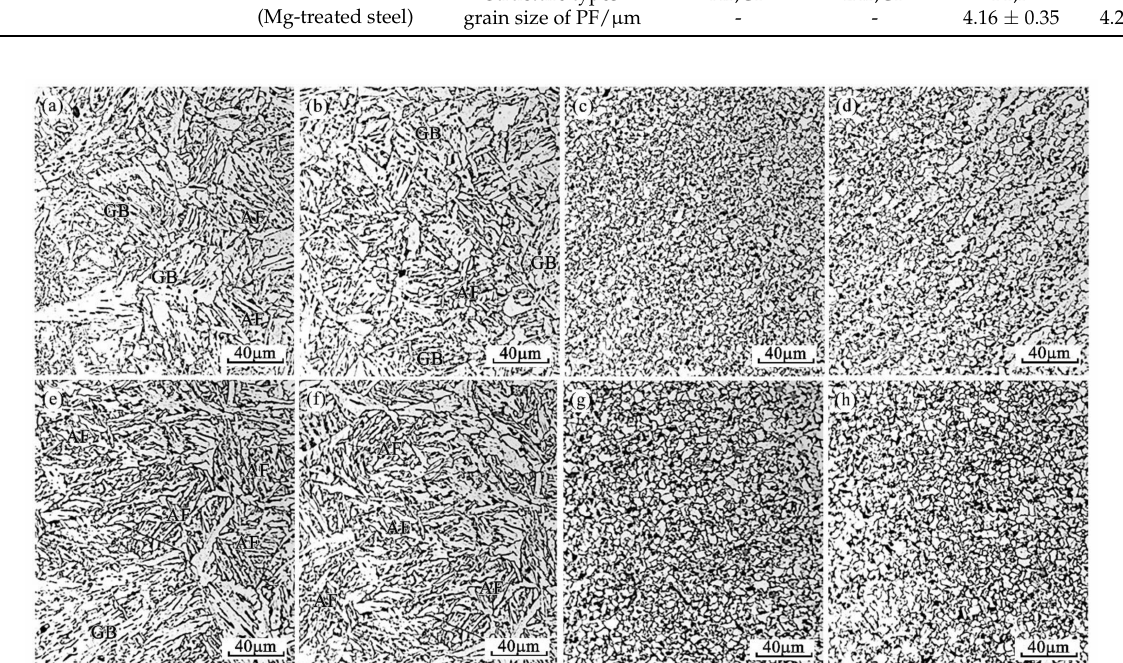
Figure 8. Microstructures of HAZ for No.2 steel. ( a – d ) CGHAZ, FGHAZ and ICHAZ under W1 procedure, ( e – h ) CGHAZ, FGHAZ and ICHAZ under W2